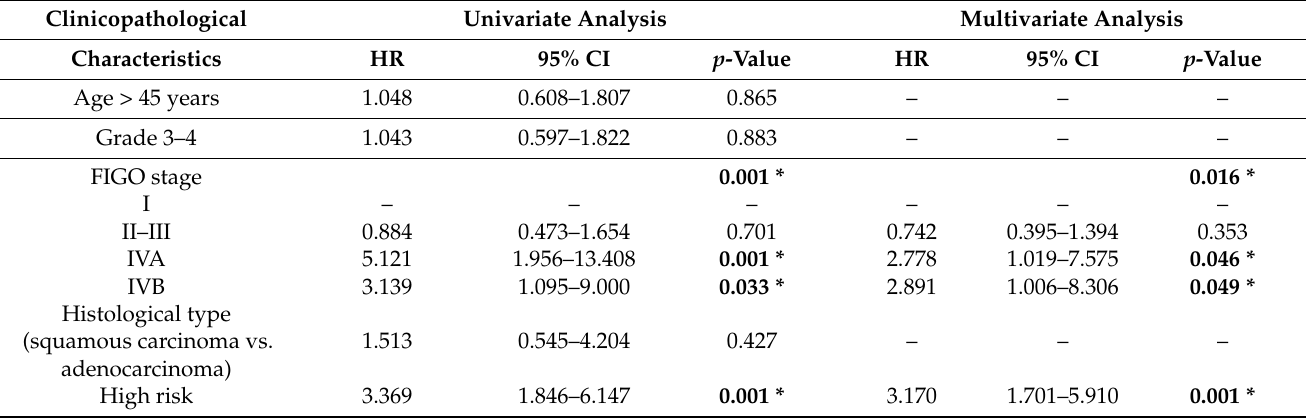
Table 4. Univariate and multivariate cox regression analyses.